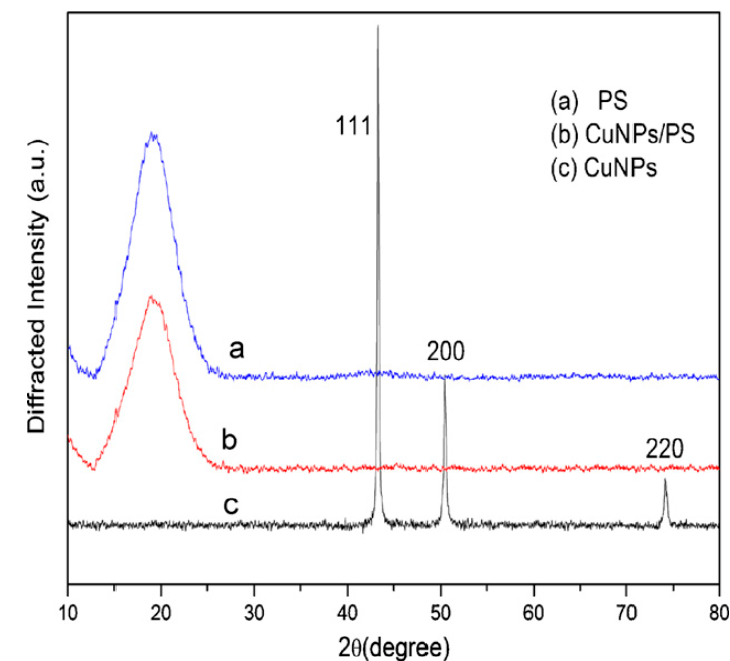
Figure 9. XRD patterns of PS, CuNPs and CuNPs/PS composites [91].